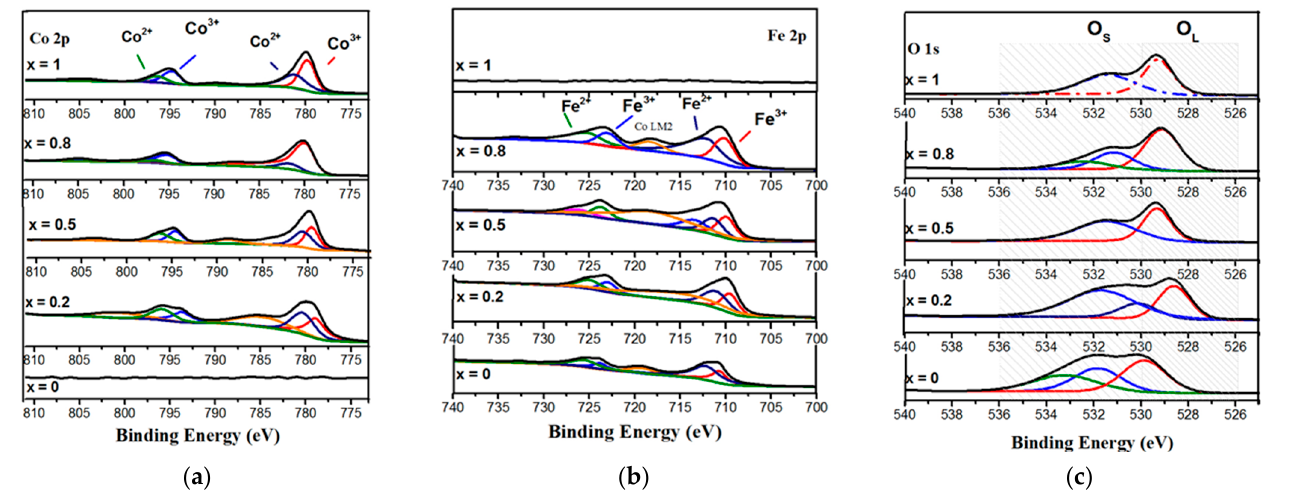
Figure 2. XPS spectra of ( a ) Co2p; ( b ) Fe2p and ( c ) O1s bands for GdFe 1 − x Co x O 3 (x = 0; 0.2; 0.5; 0.8; 1) samples. Table 2. The surface compositions of GdFe 1 − x Co x O 3 (x = 0; 0.2; 0.5; 0.8; 1) samples obtained by XPS analysis. Atomic Concentration (at. %) Atomic Samples